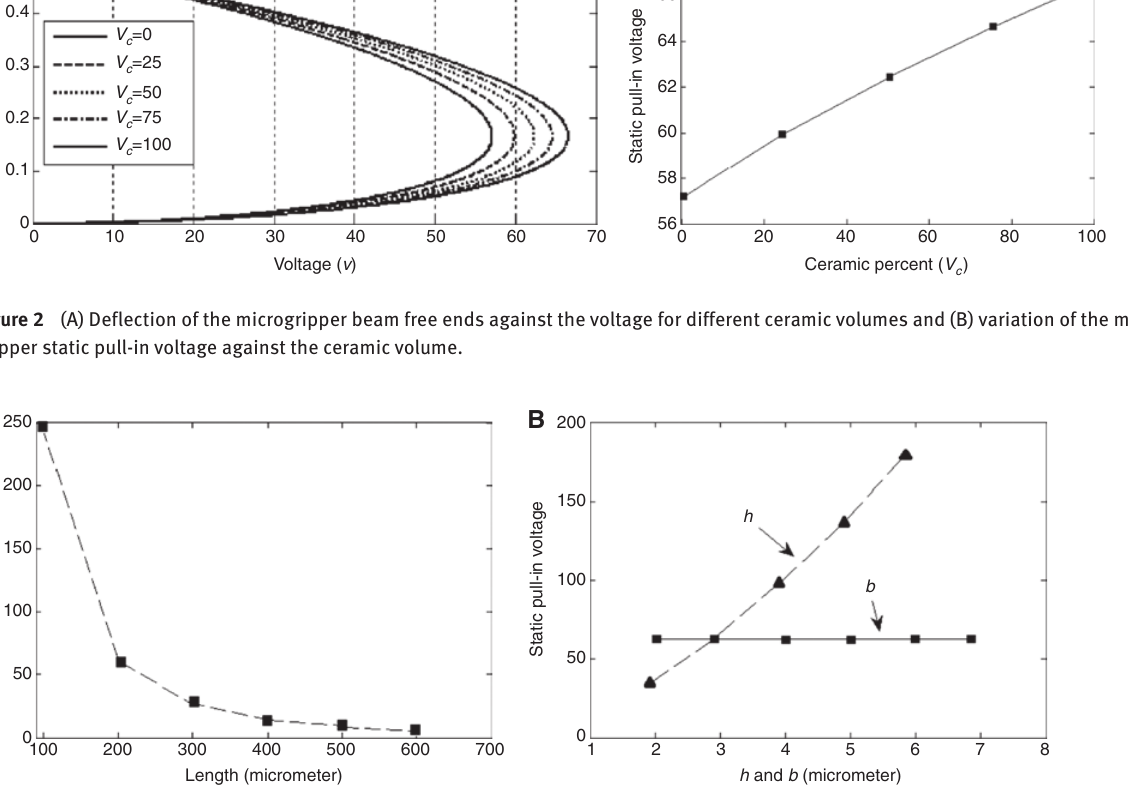
Figure 3 Effect of FGM microgripper beam geometric dimensions, (A) length and (B) thickness and width, on the static pull-in voltage for = the ceramic volume of V c